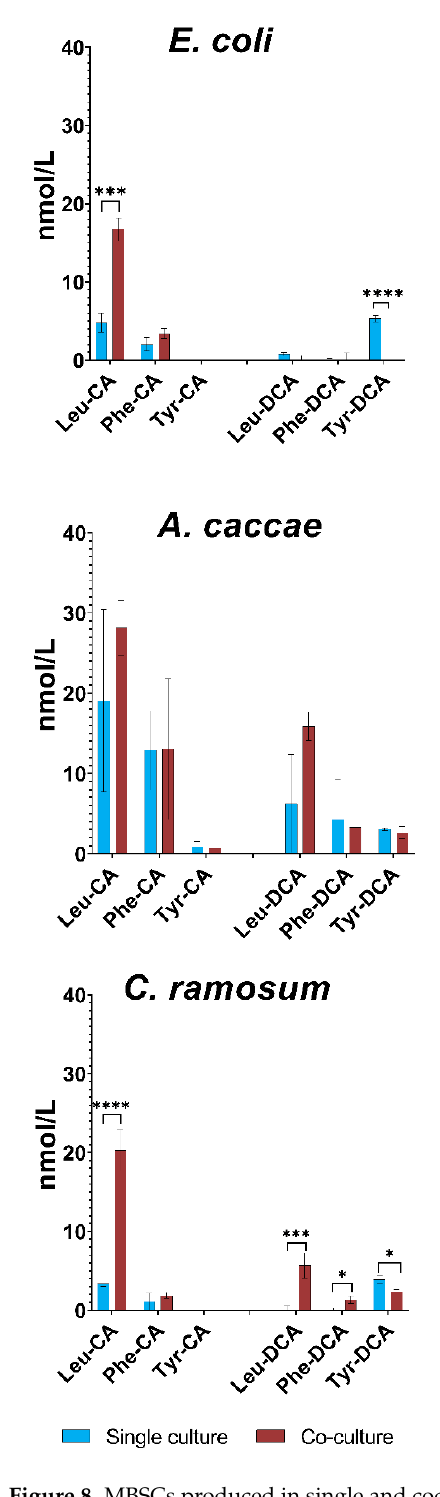
Figure 8. MBSCs produced in single and coculture. Bar charts showing the mean concentration from three biological replicates (nmol/L) of the MBSCs estimated from MS measurements of single and co-cultures. The left hand side of the graph shows the cultures stressed with CA and the right-hand side those treated with DCA. Blue colors are single cultures and red are co-cultures. Error bars are strandard deviation and statistical significance was determined using a two tailed Student’s t -test, * p < 0.05, *** p < 0.005, **** p < 0.001.